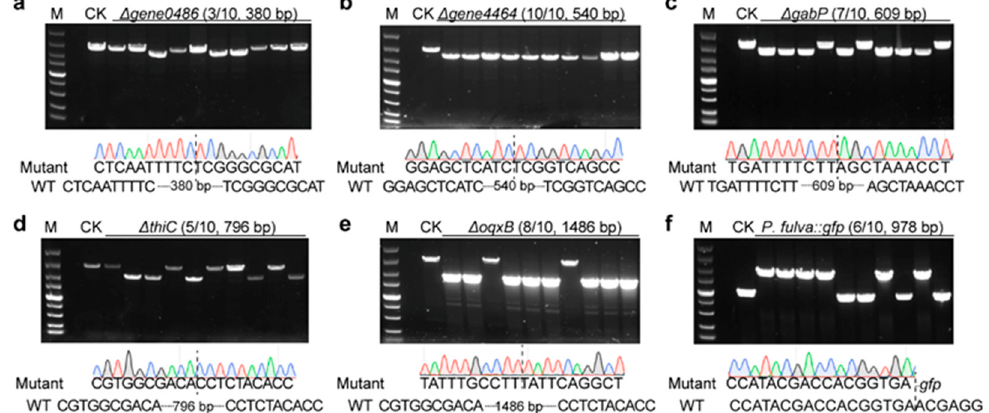
Figure 4. Analysis of multigene editing efficiencies using the developed pCasPA/pACRISPR system in P. fulva . The editing efficiency of ( a ) gene0486 (deletion of 380 bp), ( b ) gene4464 (deletion of 540 bp), ( c ) gabP (deletion of 609 bp), ( d ) thiC (deletion of 796 bp), ( e ) oqxB (deletion of 1486 bp), and ( f ) gfp (insertion of 978 bp) was verified by both agarose gel electrophoresis and Sanger sequencing. M, DNA marker (from up to down 5000 bp, 3000 bp, 2000 bp, 1500 bp, 1000 bp, 750 bp, 500 bp, 250 bp, and 100 bp).